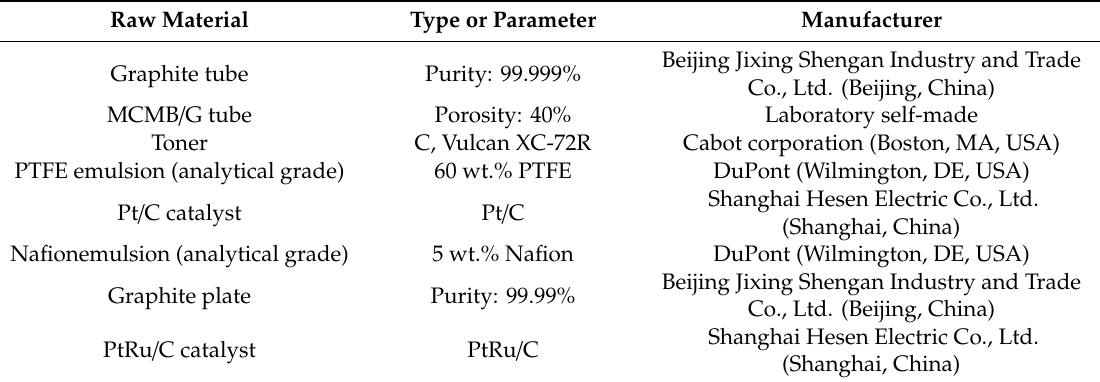
Table 1. Main raw materials and reagents.